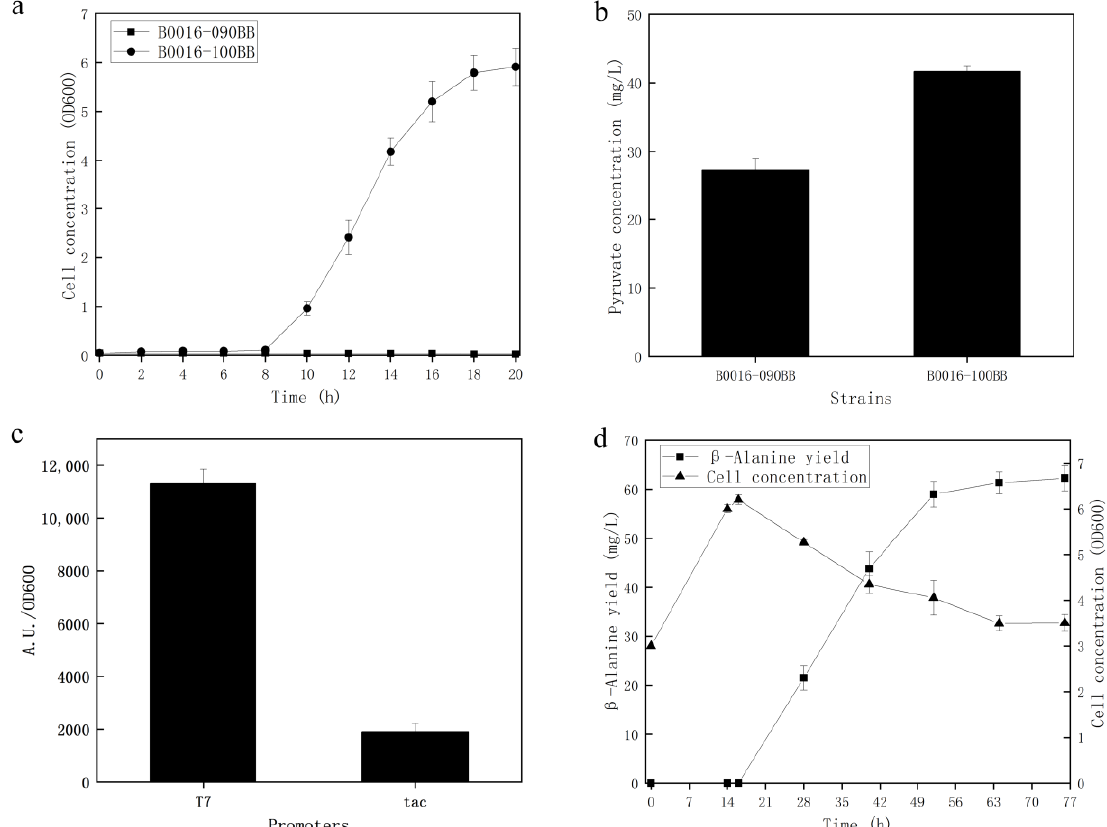
Figure 3. The profile of growth and production capability of the cell factory constructed with the guide of ALE. The growth curve ( a ) and the accumulation of pyruvate ( b ) were compared among B0016-090BB and B0016-100BB in M9 and M9Y media, respectively. The production capacity of B0016-200BB harboring the plasmid pET24a- panD - AspDH ( d ). Before bioconversion, gfp was applied as a reporter gene to compare the expression strength of tac and the T7 promoter ( c ) to optimize the expression